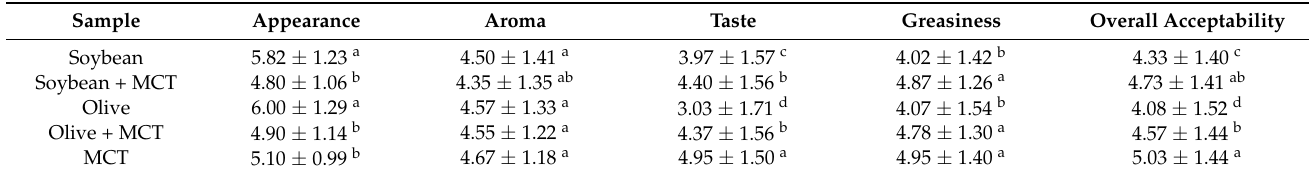
Table 6. Sensory evaluation of the mayonnaise